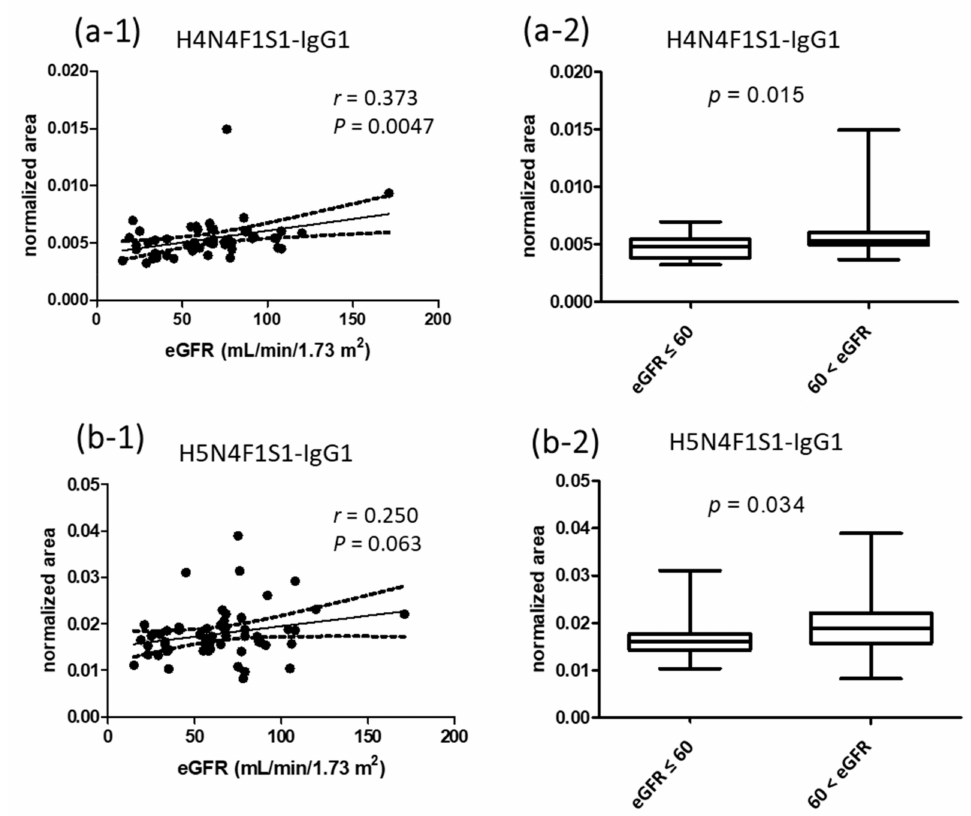
Figure 4. Correlations of the normalized area of H4N4F1S1-IgG1 and H5N4F1S1-IgG1 to the values of eGFR from 56 participants ( a - 1 , b - 1 ). Statistical analysis of the normalized area of H4N4F1S1-IgG1 and H5N4F1S1-IgG1 between groups with eGFR values lower and higher than 60 mL/min/1.73 m 2 ( a - 2 , b - 2 ). r is Spearman’s r . The peak area of each target was normalized to the peak area of the internal standard, DSTYSLSSTLTLSK, and also the responses of